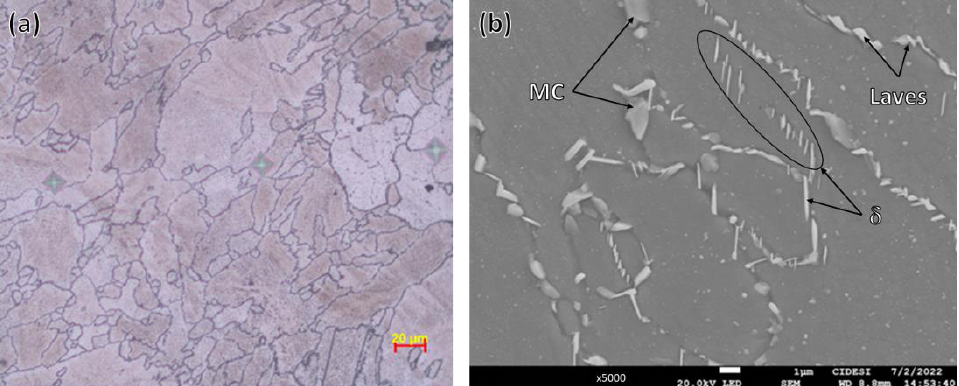
Figure 4. Microstructure of cellular IN718 after heat treatment with 6 h of aging. ( a ) Optical microscopy at 500×. ( b ) SEM image at 5000×.